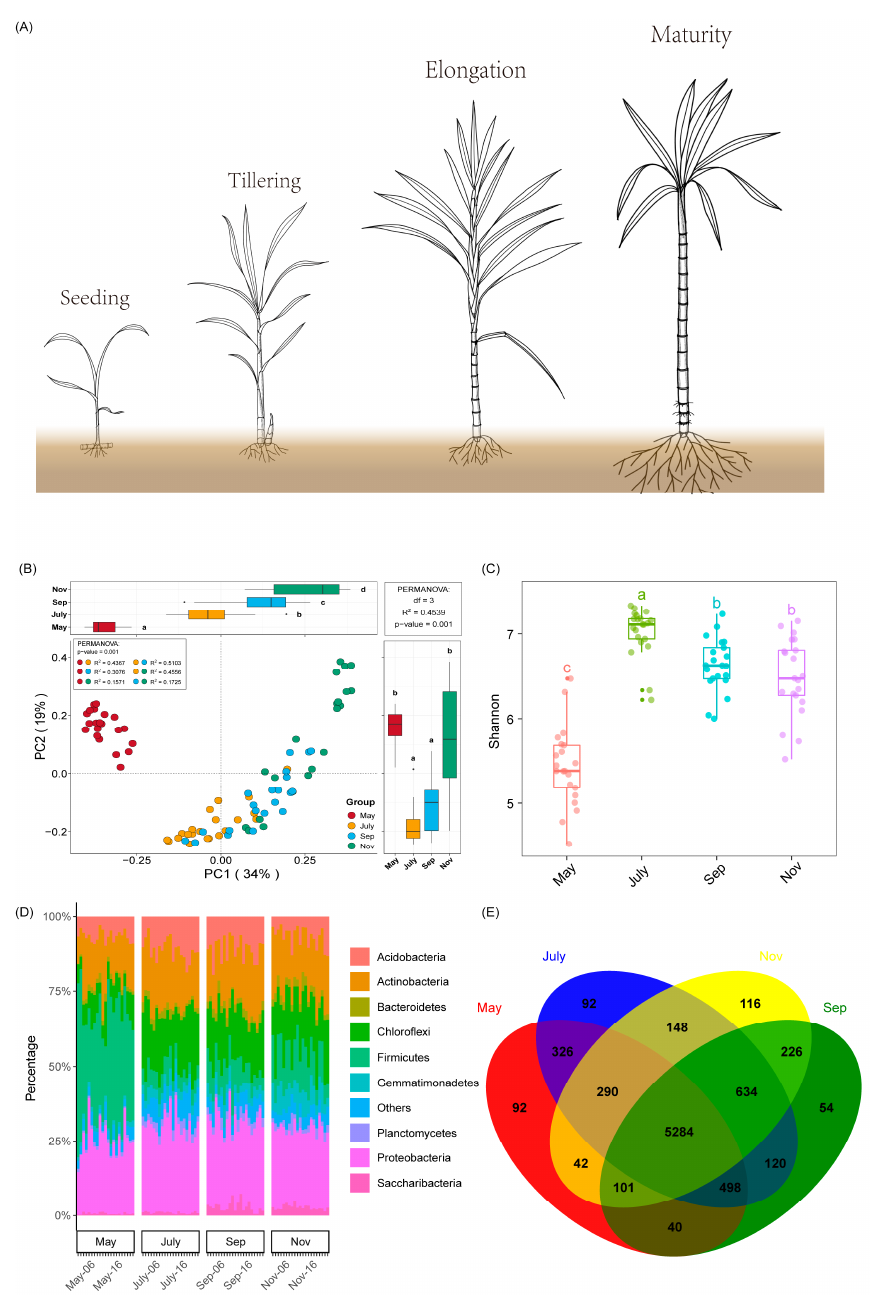
Figure 2. ( A ) Seasonal growth model of sugarcane. ( B ) Unconstrained PCoA (for principal coordinates PC1 and PC2) with Bray-Curtis distance. ( C ) The Shannon index of soil microbial populations in roots of sugarcane at different growth stages. ( D ) Phylum-level distribution of rhizosphere soil in different growth stages of sugarcane. ( E ) Venn diagram of the core OTU of the rhizosphere soil of sugarcane at different growth stages. Different letters indicate significantly different among the different time